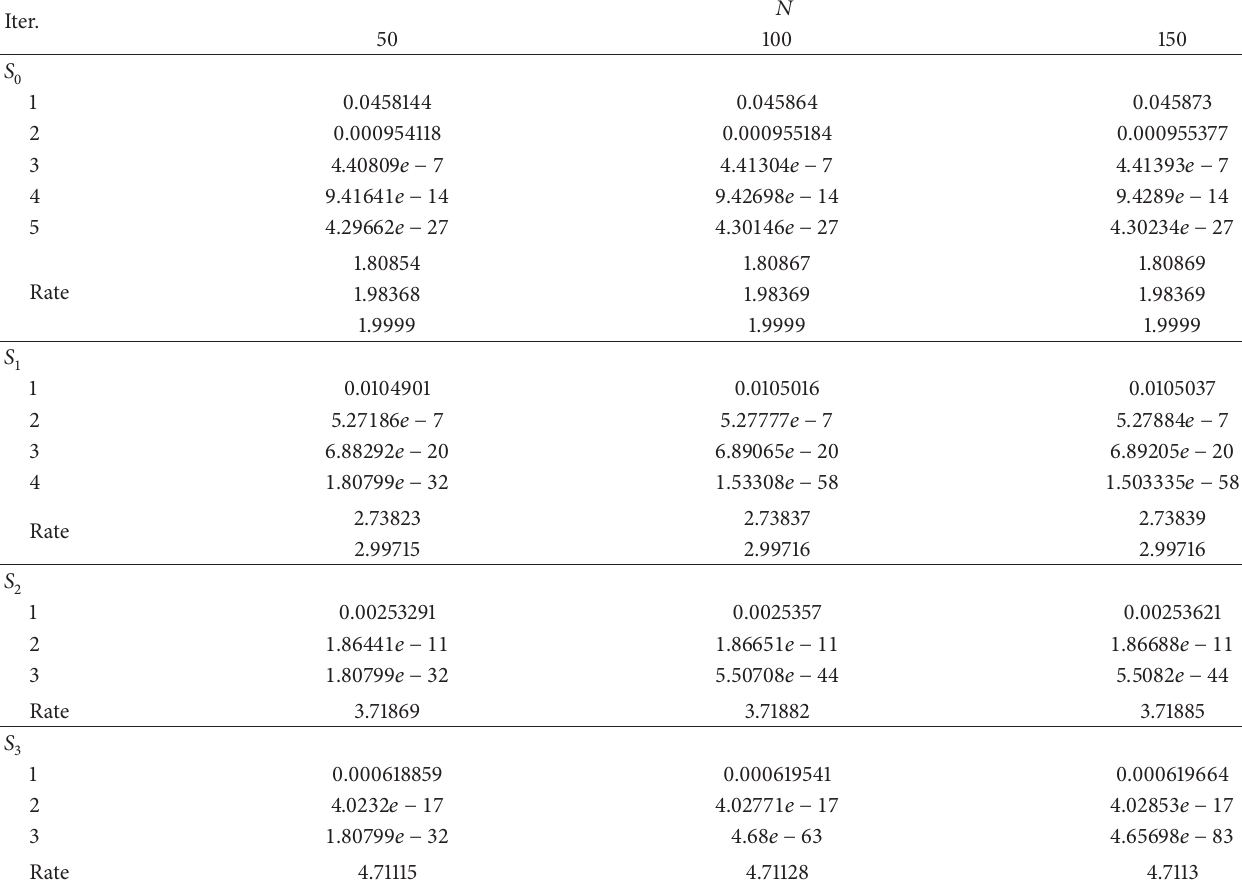
Table 2: Convergence order for Bratu problem for 𝜆 = 3 and different values of 𝑁 . Iter.